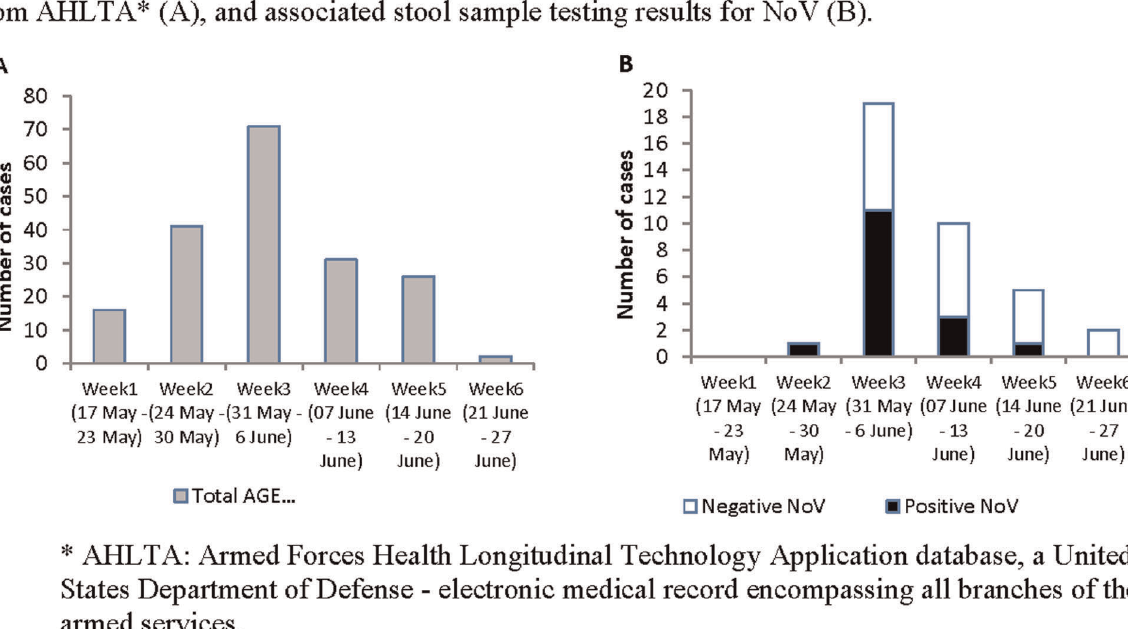
Figure 1. Distribution of AGE cases from 18 May –23 June 2009 evaluated in the clinic identified from AHLTA* (A), and associated stool sample testing results for NoV (B).